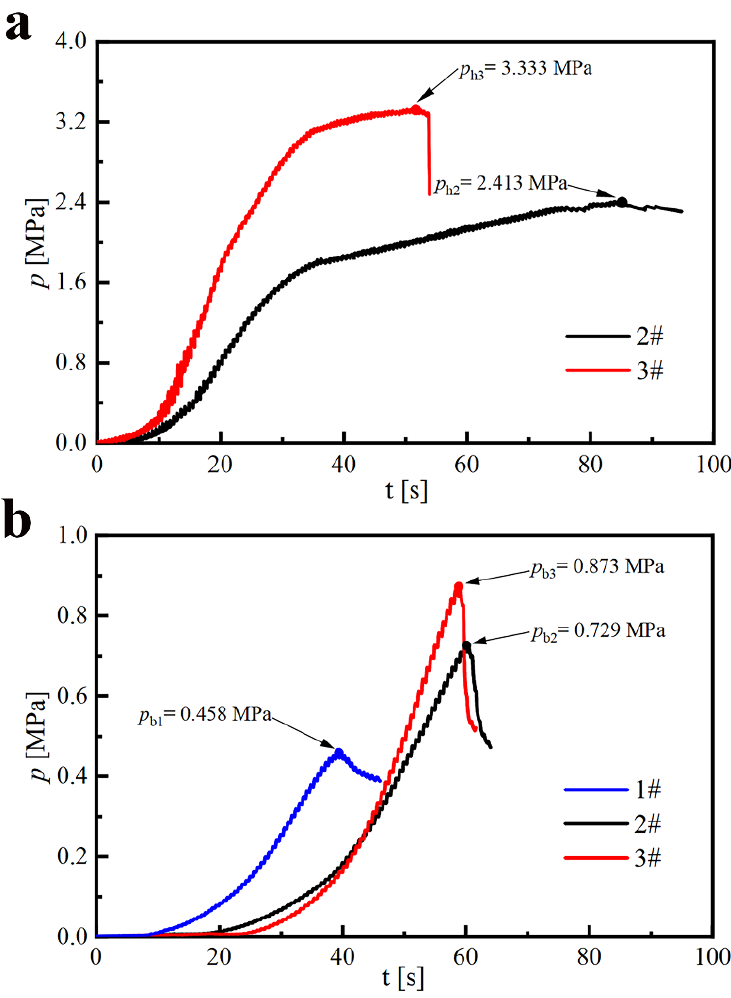
Figure 16. Pressure histories recorded from hydroforming tests of two preformed toroids ( a ) and from hydrostatic tests of two hydroformed toroids and one preformed toroid ( b ).